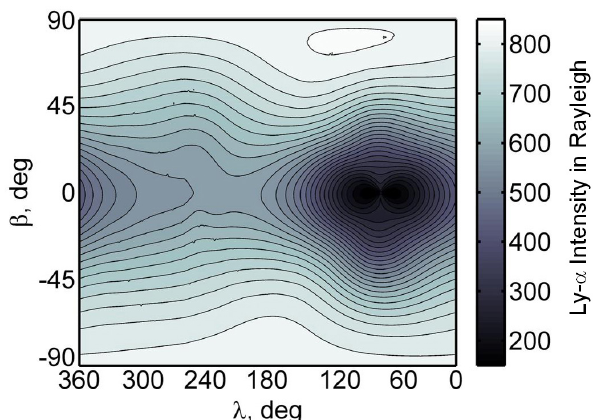
Fig. 3. Interplanetary Lyman- α glow intensity all-sky-map of 11 June 2008 derived from SOHO/SWAN-data and solar anisotropy measurements (W. Pryor and R. Gladstone, private comunication, 2011) in geocentric, ecliptical